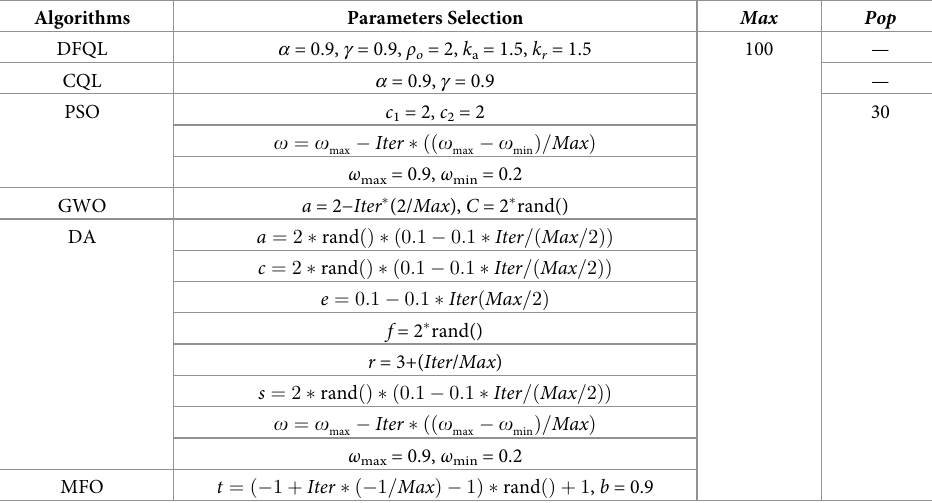
Table 1. Parameters setting of DFQL, CQL, PSO, GWO, DA, and MFO.